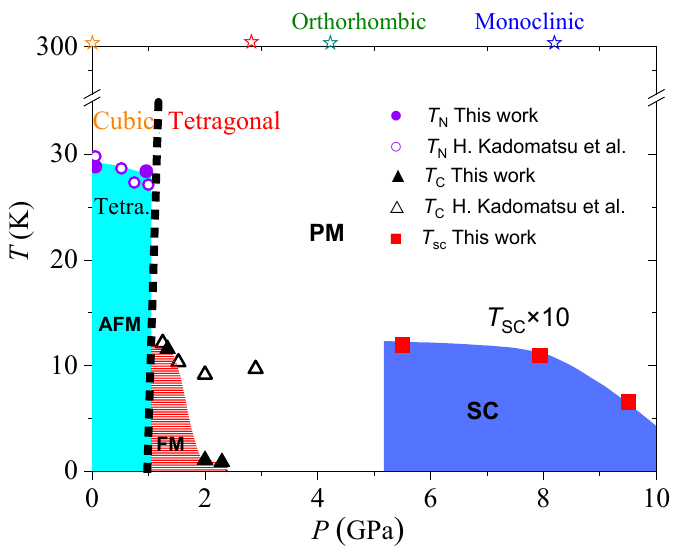
Figure 4. Temperature-pressure phase diagram of CeZn. T N , T C, and T sc are the N é el temperature, the Curie temperature and the superconducting transition temperature determined from the resistivity data, respectively. For clarity, T sc has been multiplied by a factor of 10. The stars indicate the pressure value at which the single crystal X-ray diffraction measurements are performed. The tetragonal structure in the AFM region is obtained from Refs. [10,12]. The cubic to the tetragonal structure boundary line has been used from Ref. [9].